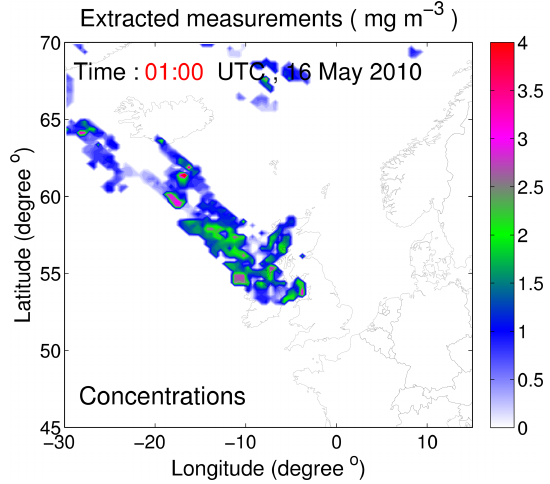
Figure 3. Extracted ash concentrations by the satellite observational operator (at 16 May 2010 at